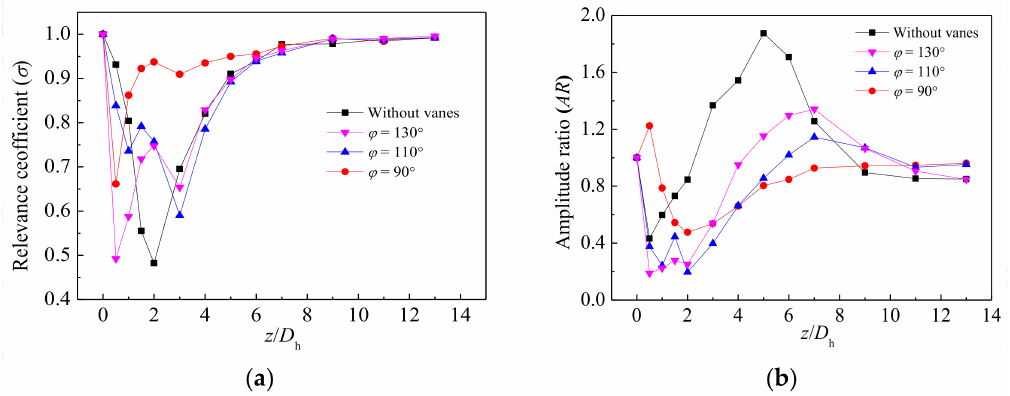
Figure 16. Relevance coefficients ( a ) and amplitude ratios ( b ) with different angle of the vanes at R =